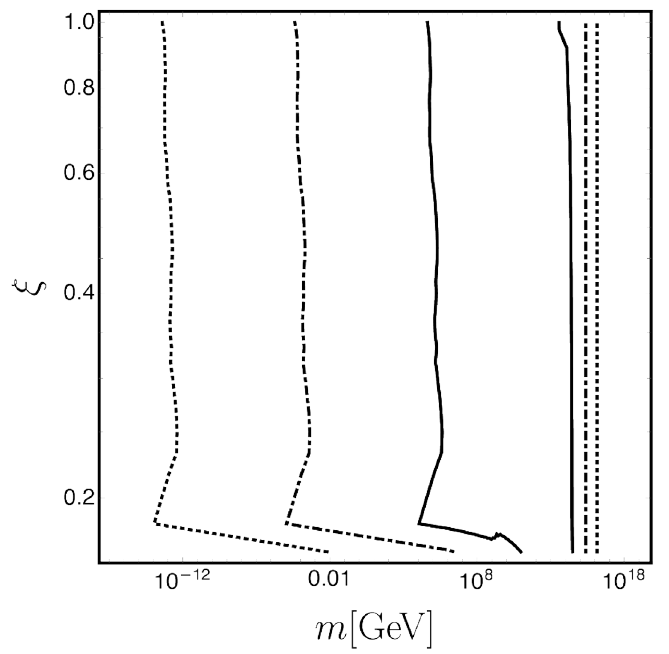
Figure 9 . The constraints on the (cid:12)eld parameter space are represented through the contours corresponding to the observed abundance: (cid:10) = 0 : 268 for di(cid:11)erent reheating temperatures. The ones obtained for a speci(cid:12)c reheating temperature T rh = 10 15 GeV are displayed in solid line. In dot-dashed line we plot the same constraints but for T rh = 10 12 GeV and (cid:12)nally they are displayed in dotted line for T rh = 10 9